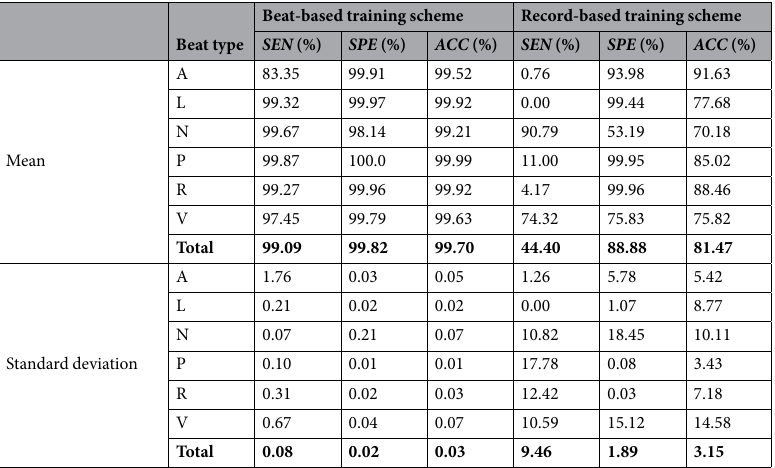
Beat-based training scheme Record-based training scheme Beat type